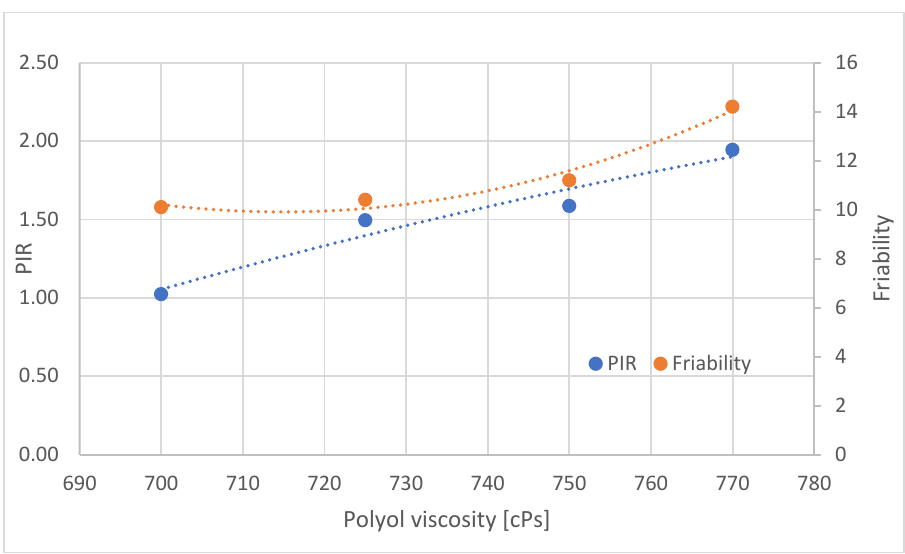
Figure 20. Proportion of PIR and brittleness groups in samples taken from part B of foam blocks. Increasing the viscosity of the polyol is associated with an increase in the proportion of PIR groupings in the central part of the block and an increase in brittleness (Figure 20). In the central part of the foam blocks (B), with increasing polyol viscosity, the proportion of PIR increases. The increasing viscosity is the result of a reduction in the temperature of the polyol and, therefore, also of the substrate mixture, with increasing viscosity reducing the mobility of raw materials, yet the proportion of PIR groupings formed increases. The likely reason for the increase in the proportion of PIR as the viscosity of the polyol in- creases is the longer retention of heat generated by the reaction. With increasing polyol viscosity, the brittleness of the foams also increases. The PIR groupings stiffen the polyu- rethane macromolecules, resulting in reduced mobility and, consequently, increased brit- tleness. 4. Discussion and Conclusions The foaming process of polyurethane foams was carried out using various machines, including machines in which mixing was carried out at high pressure. This paper analyzes the effect of mixing pressure in the range of 110 – 170 bar on the structure and properties of the blocks. This paper analyzed the change in the characteristics of foams from the outer part of the blocks (A) and the middle part (B). As a result of these analyses, it was found that foams made at 170 bar differ in properties from foams made at pressures of 110 – 150 bar. Foam from a block made at a mixing pressure of 170 bar is characterized by pores of the largest size in the range of 420 – 490 m, and at other pressures 390 – 440 m. Foam made at 170 bar contains the fewest closed pores and pores with the largest wall thickness. The apparent density of this foam is the lowest, but its brittleness is the highest, and its com- pressive strength is the lowest. Differences in properties between the inner and outer parts of the foam blocks were also observed. In the course of analyzing the foams, it was found that in addition to mixing pressure, the temperature of the substrates also influenced their properties. However, the substrate temperature recommended by machine suppliers was used in the foam synthesis process. The temperature of the substrates affects viscosity during mixing, and this affects the chemical structure of the foam blocks. It was shown that the proportion of urea bonds in the foams, the index of hydrogen bonds in the hard phase of the foams and the proportion of isocyanurate groups changed. In the middle part of the foams, no big differences were observed in the share of urea bonds and the index of hydrogen bonds connecting the hard